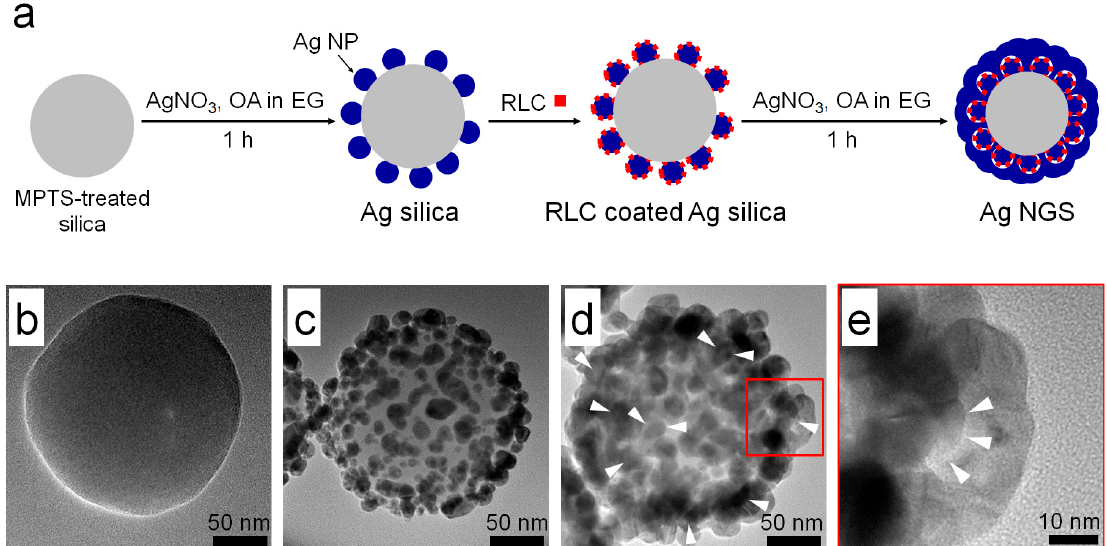
Figure 1. Synthesis and characterization of silver nanogap shell (Ag NGS) particles as near-infrared active surface-enhanced Raman scattering (SERS) nanoprobes. ( a ) Schematic illustration of the method used to prepare Ag NGS particles. Representative TEM images of ( b ) thiol-functionalized silica, ( c ) Ag silica, ( d ) Ag NGS, and ( e ) the interior gap structure of Ag NGS (white arrow heads) at high magnification.